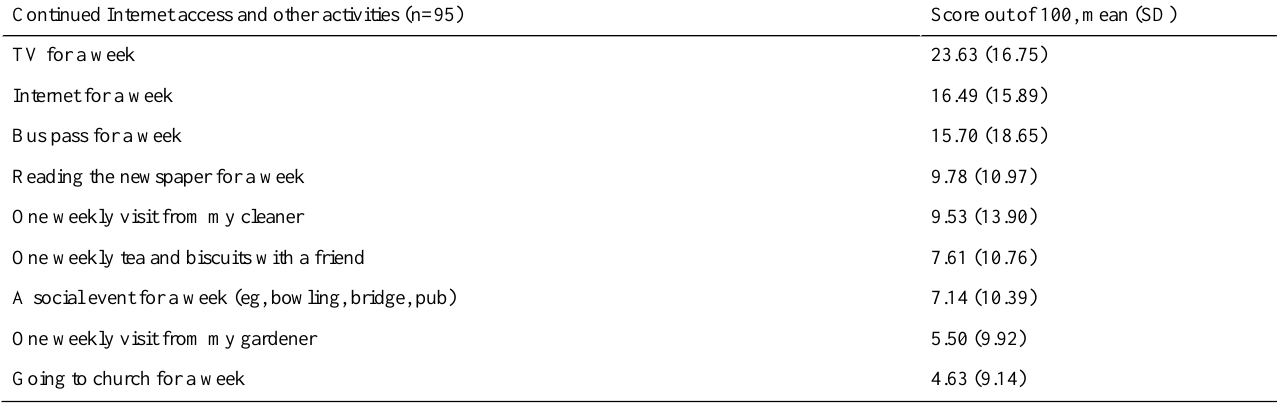
Table 7. Value of keeping Internet access compared to other activities based on answers to question 4 from the Value of Participation postal survey: Which of these do you really not want to give